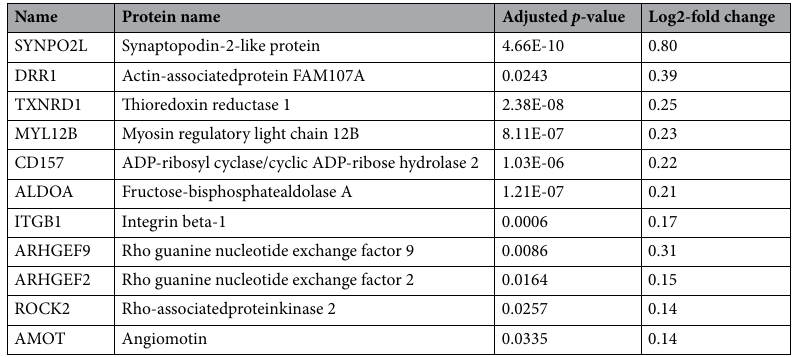
Table 1. Genes associated to the actin cytoskeleton. Selection of DEG’s annotated to significantly enriched GO-terms associated to inflammation and cell death. The portrayed genes were selected due to possible biological significance for podocyte health. Adjusted p -value was considered significant at p < 0.05.